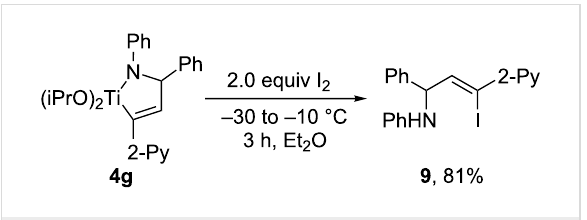
at − 30 °C followed by warming to − 10 °C and stirring for 3 h, iodinated allylic amine 9 could be isolated in 81% yield. Com- pound 9 is highly valuable since further functionalization could be explored to synthesize a wide range of organic